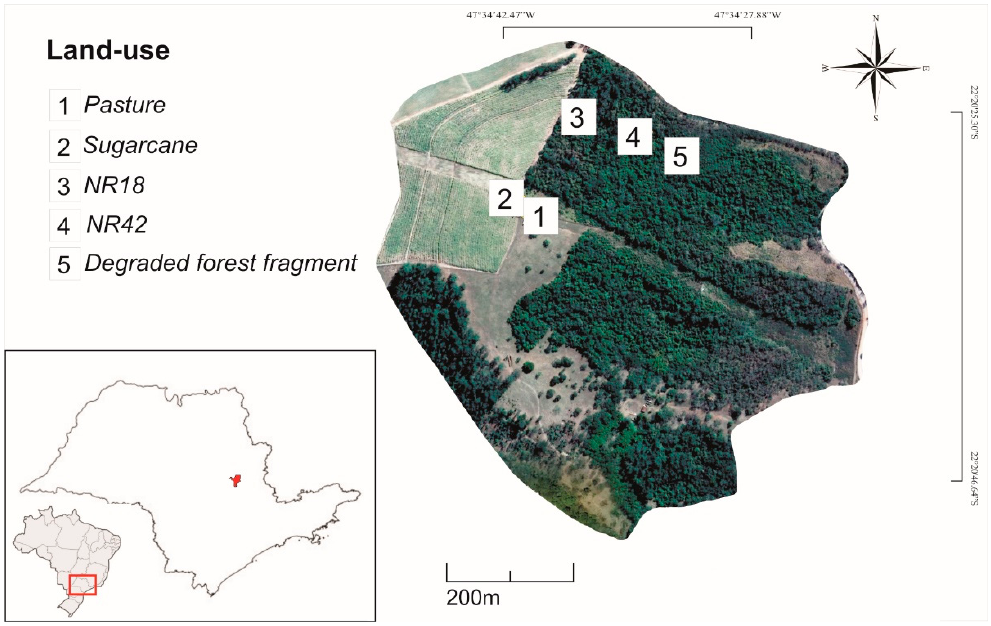
Figure 1. Location of the study areas in the state of São Paulo, Southeast Brazil. NR18: Natural regeneration 18 years; NR42: Natural regeneration 42 years.